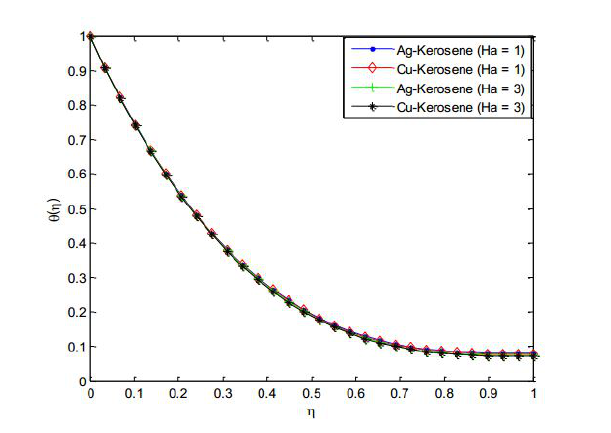
Figure 7. Effect of Magnetic field parameter (Hartmann number) on the fluid temperature